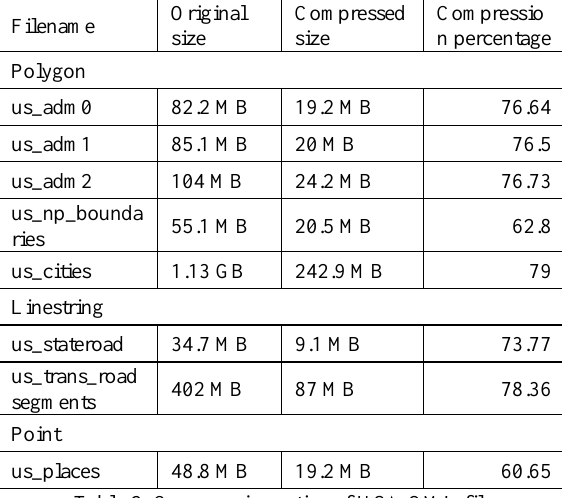
Table 2. Compression ratios of USA GML